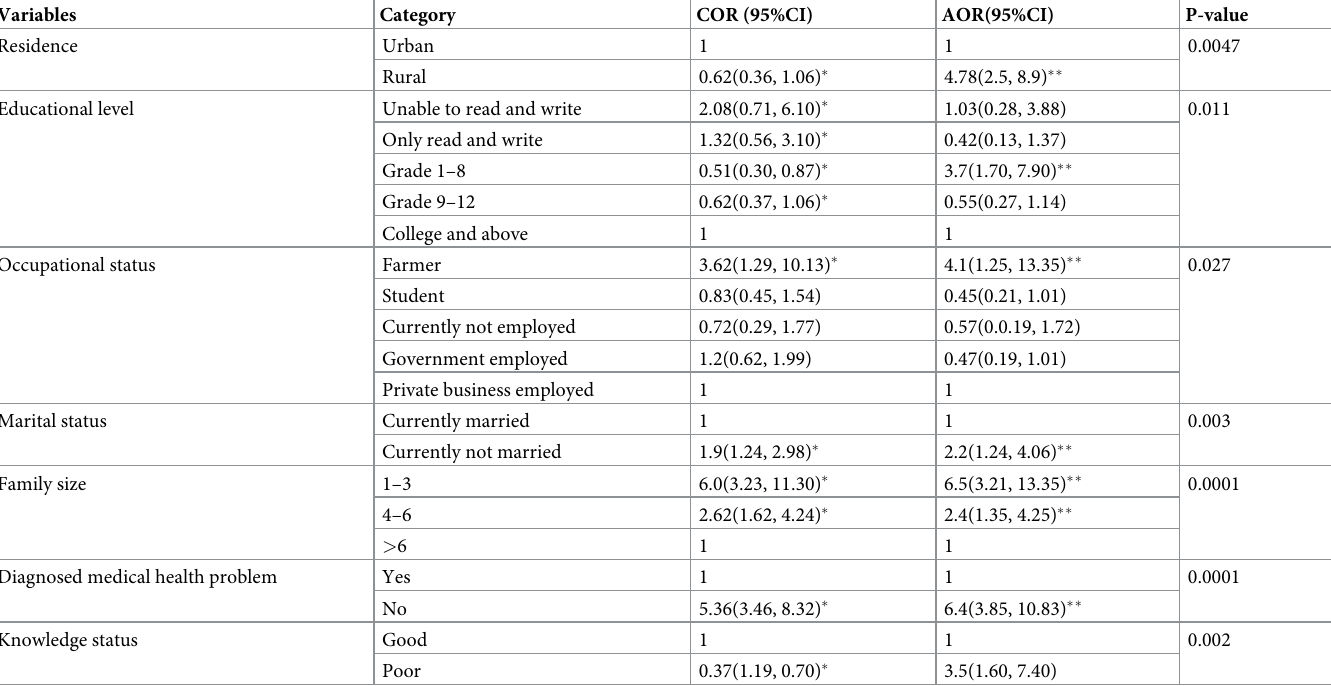
Table 6. Factors associated with the applicability of the basic preventive measures of the pandemic COVID-19 among residents in Guraghe Zone, 2020 (n =